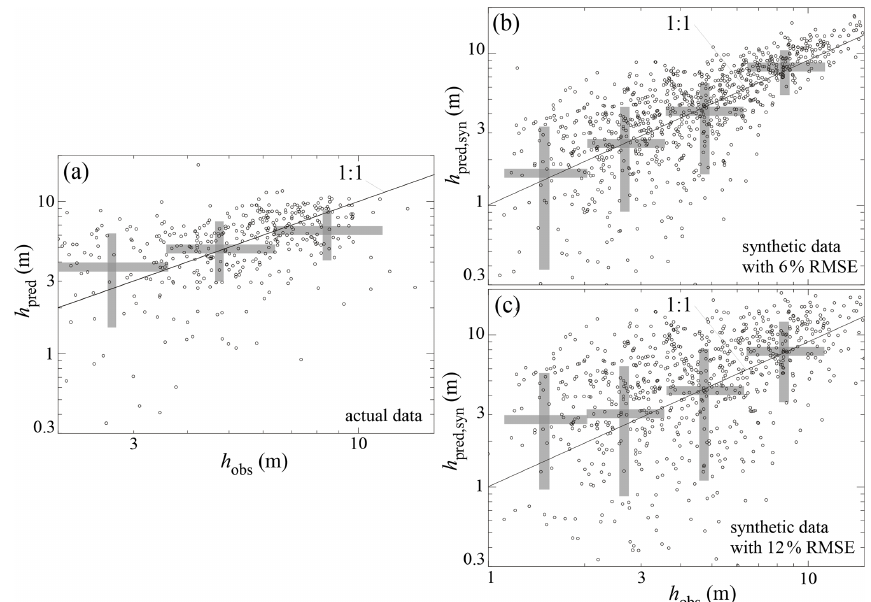
Figure 2. Plots of predicted bank-full depths, h pred , calculated using Eq. (5) versus observed bank-full depths, h obs , estimated based on the bends in the stage–discharge rating curves: (a) actual data and (b, c) synthetic data (Eq. 6) with (b) σ = 6% and (c) σ = 12%, respectively. The small open circles are individual data points, and the gray rectangles illustrate the geometric means and standard deviations within each logarithmically spaced bin. The gray rectangles are for visualization purposes only – no analyses are performed on these